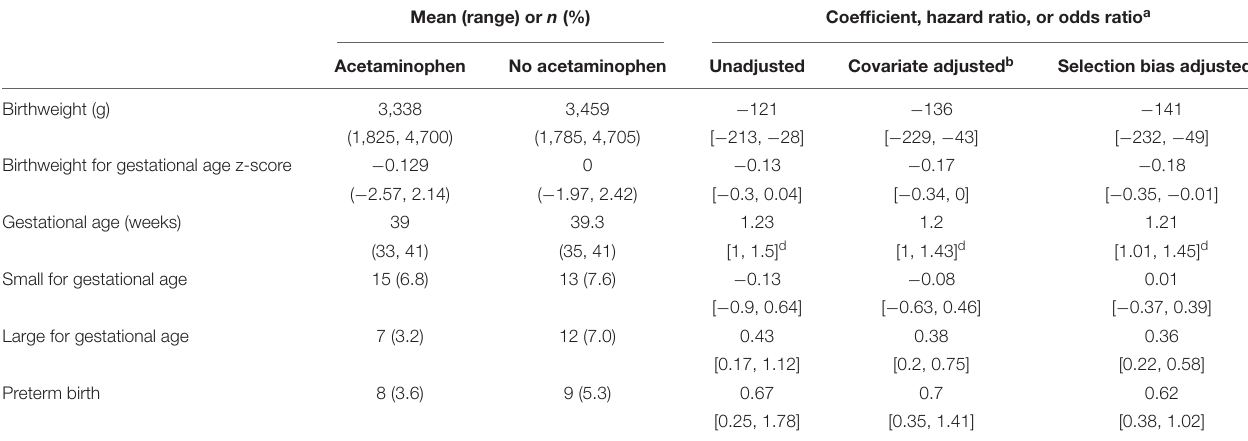
TABLE 2 | Association of meconium acetaminophen with birth outcomes ( N = 393). Mean (range) or n (%) Coefficient, hazard ratio, or odds ratio a